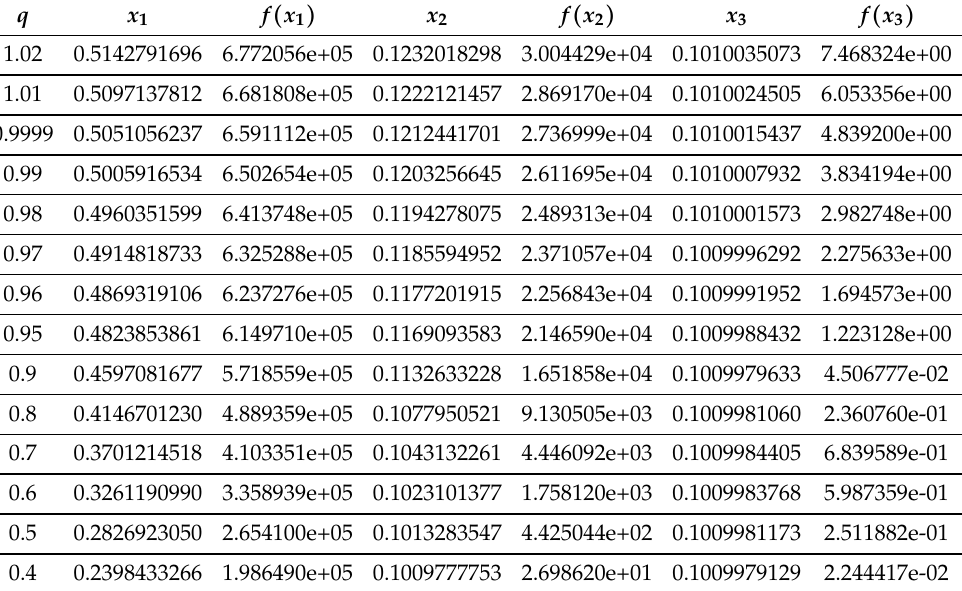
Table 3. The computed values of x i and f ( x i ) for i = 1,2,3 and different values of q by using QAG